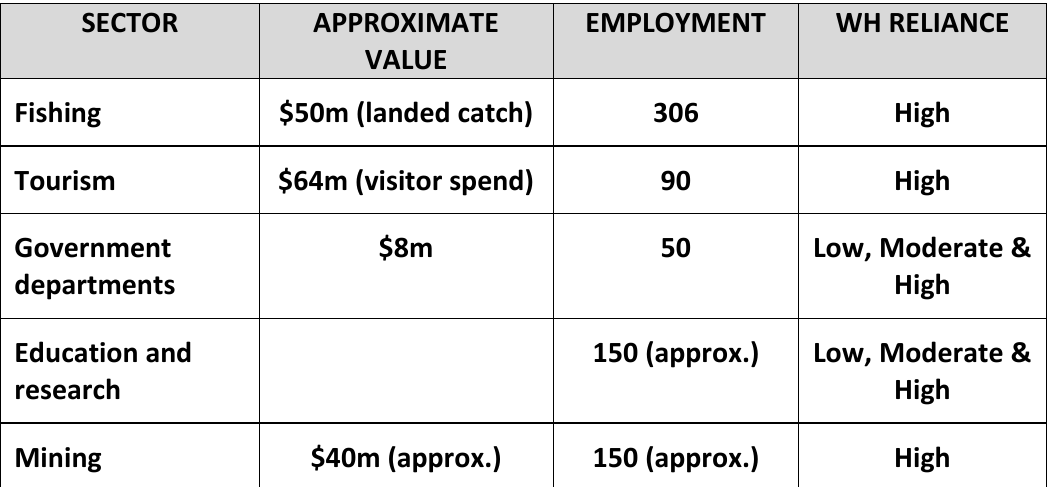
Table 3.1 Approximate Economic value, employed participants and World Heritage